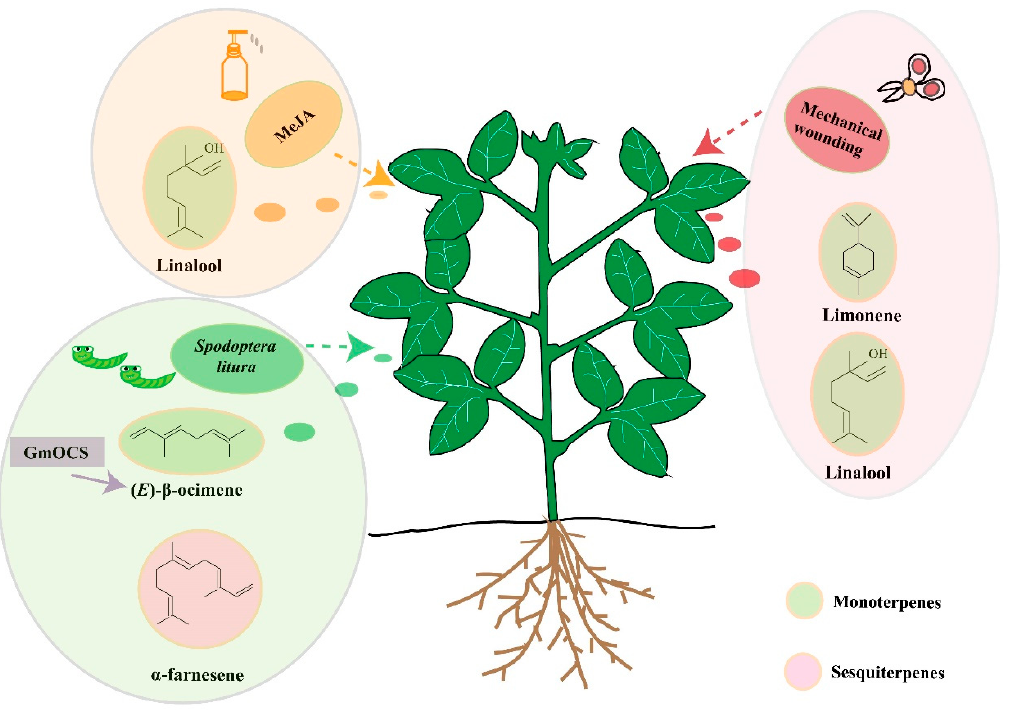
Figure 7. Proposed model of soybean terpene releases responded to MeJA, mechanical wounding, and Spodoptera litura treatments . Chemical molecules highlighted by green or pink background represented monoterpenes and sesquiterpenes, respectively.